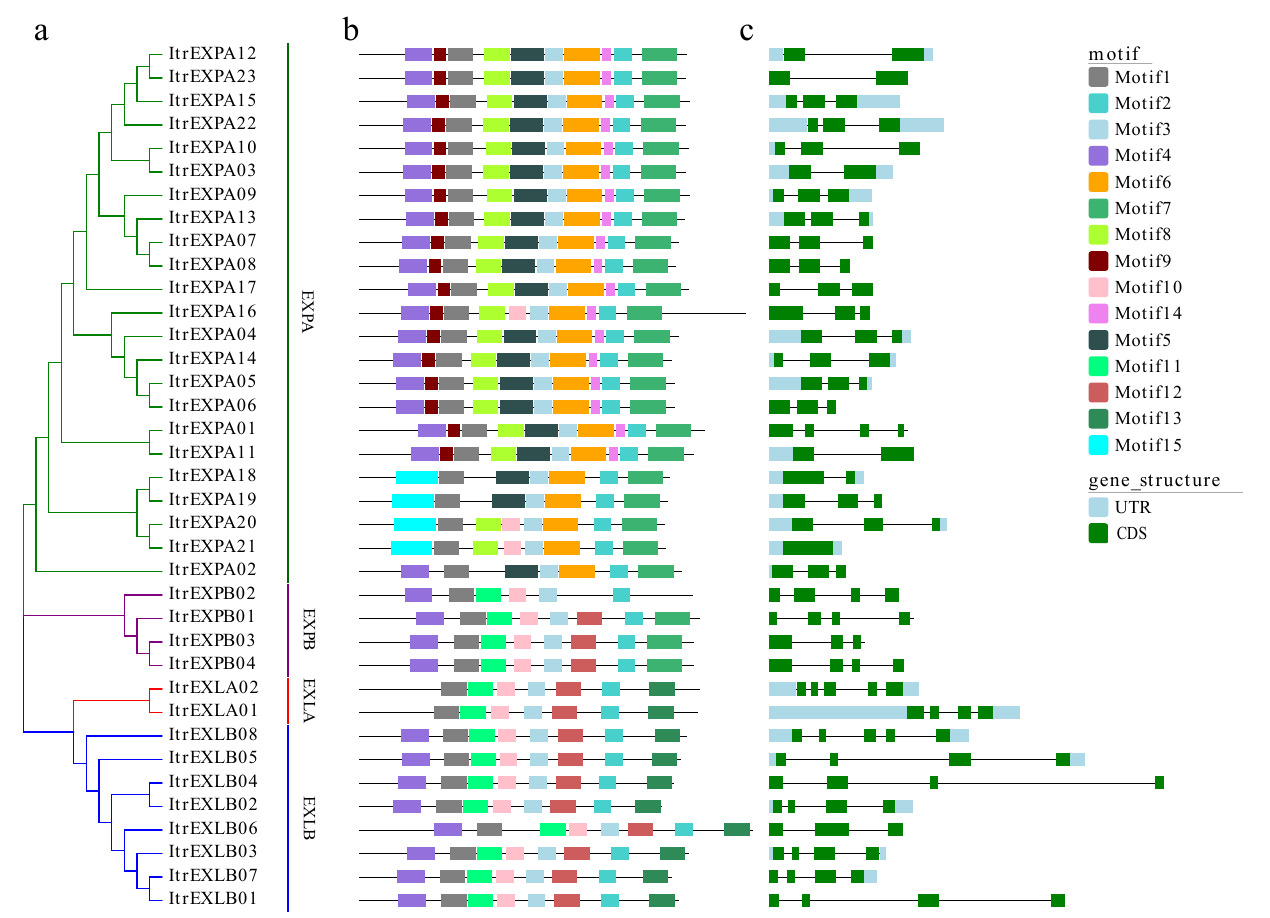
Figure 3. Phylogenetic relationships, motif compositions and gene structure of expansins in Y22. ( a ) Phylogenetic tree of 37 ItrEXPs in Y22. The expansins were classified into α -expansin (ItrEXPA), β -expansin (ItrEXPB), expansin-like A (ItrEXLA) and expansin-like B (ItrEXPB) groups. ( b ) Different motif compositions of ItrEXPs; the conserved motifs are represented by boxes with different colors, and their protein sequences are listed in Supplementary Table S5. ( c ) Gene structure organization of ItrEXPs ; the introns and exons are also marked in the